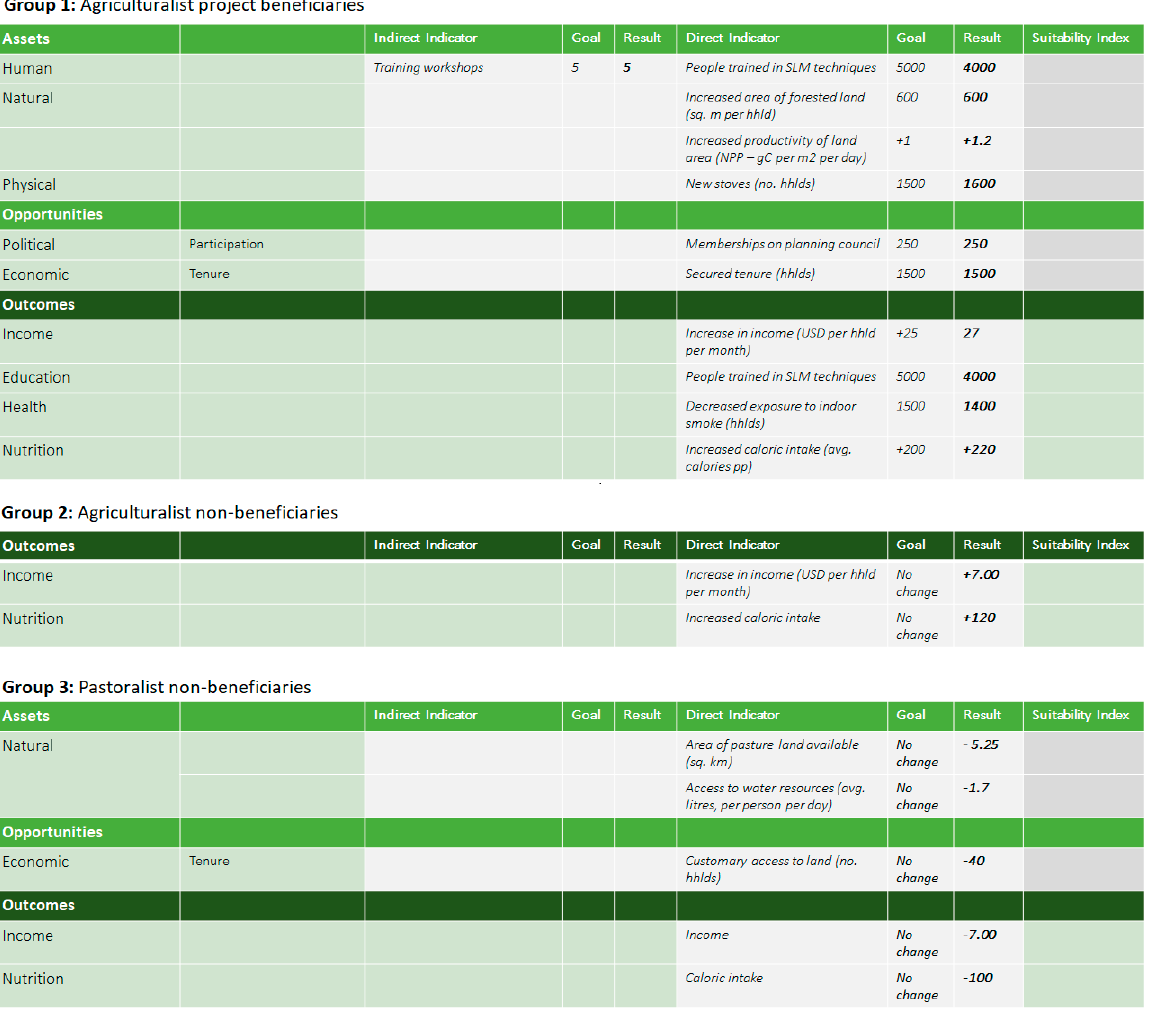
Figure 5. Worked example: evaluation of a simple forestry intervention using the framework. This evaluation focuses on direct measurement of impacts, even when these impacts are second-order effects of the intervention, as is the case with the effects on non-beneficiary groups.